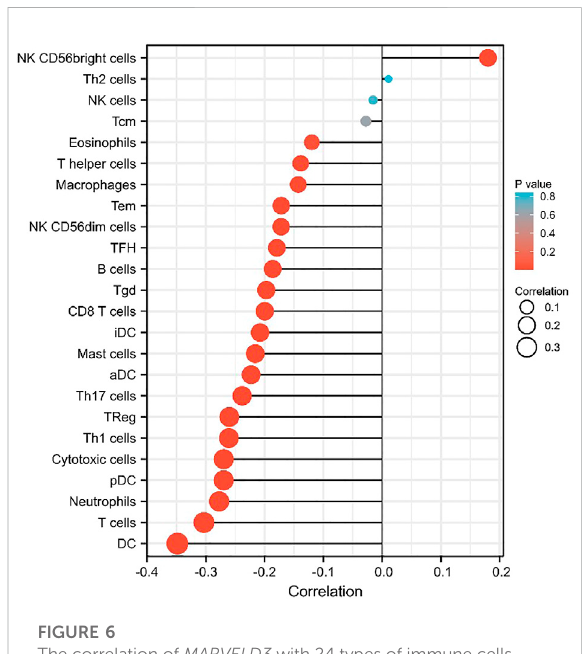
FIGURE 6 The correlation of MARVELD3 with 24 types of immune cells in